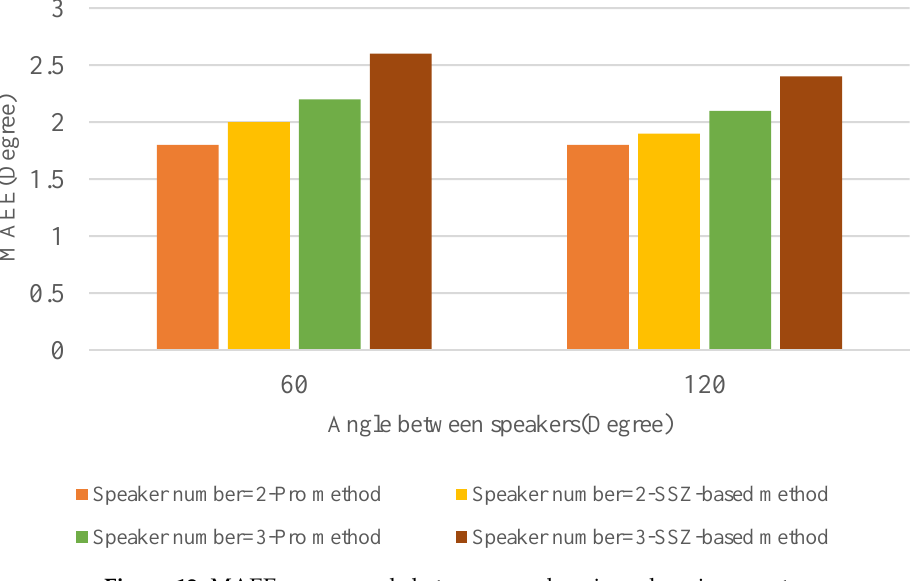
Figure 12. MAEE versus angle between speakers in real environments.